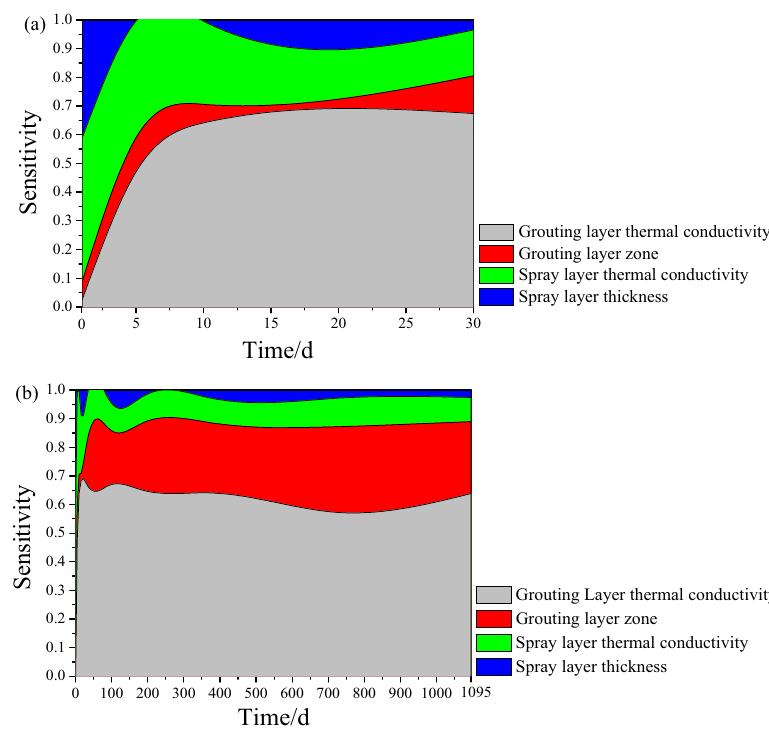
Figure 23: Sensitivities of different influencing factors to wall temperature: ( a ) 30 days; ( b ) 1,095